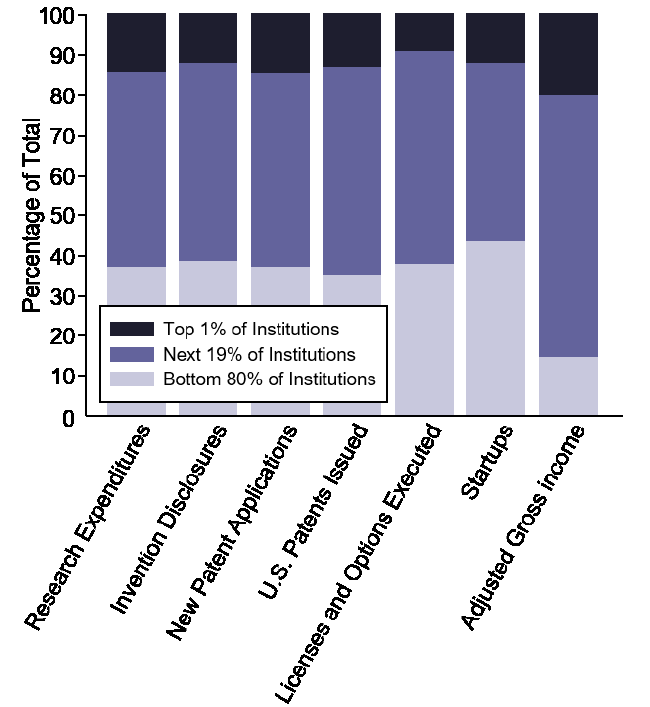
Figure 2. Contribution by top 1%, top 20% and bottom 80% of institution to each step of the commercialization pipeline. A small number of institutions contribute to the majority of commercialization